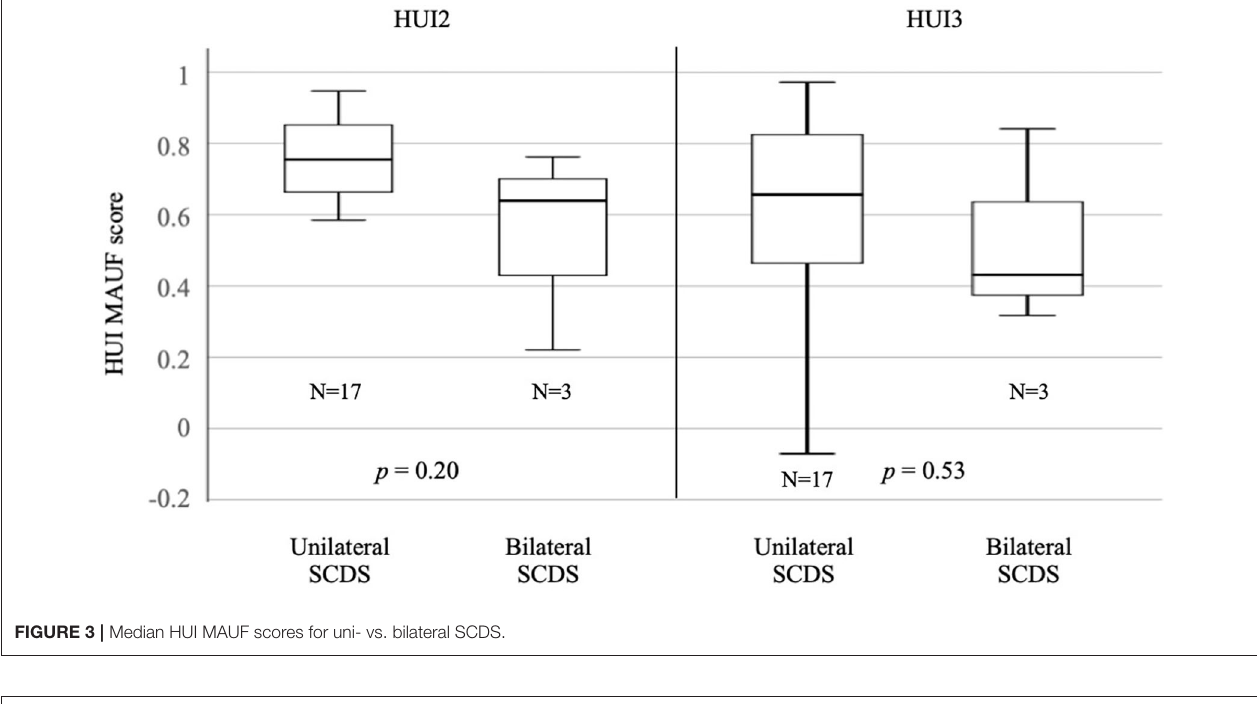
FIGURE 3 | Median HUI MAUF scores for uni- vs. bilateral SCDS.